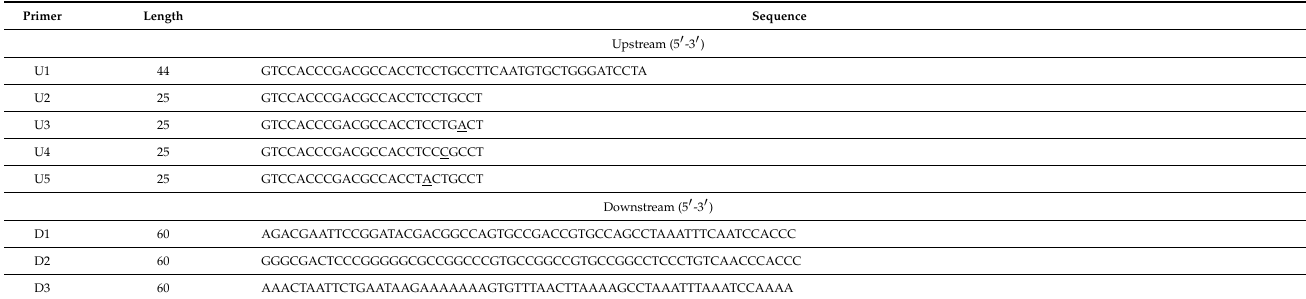
Table 1. Oligonucleotide